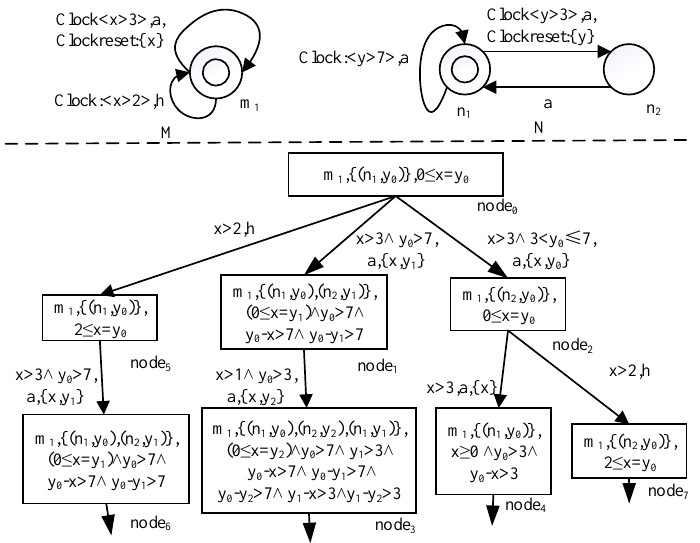
Figure 8. Synchronous product based on zone